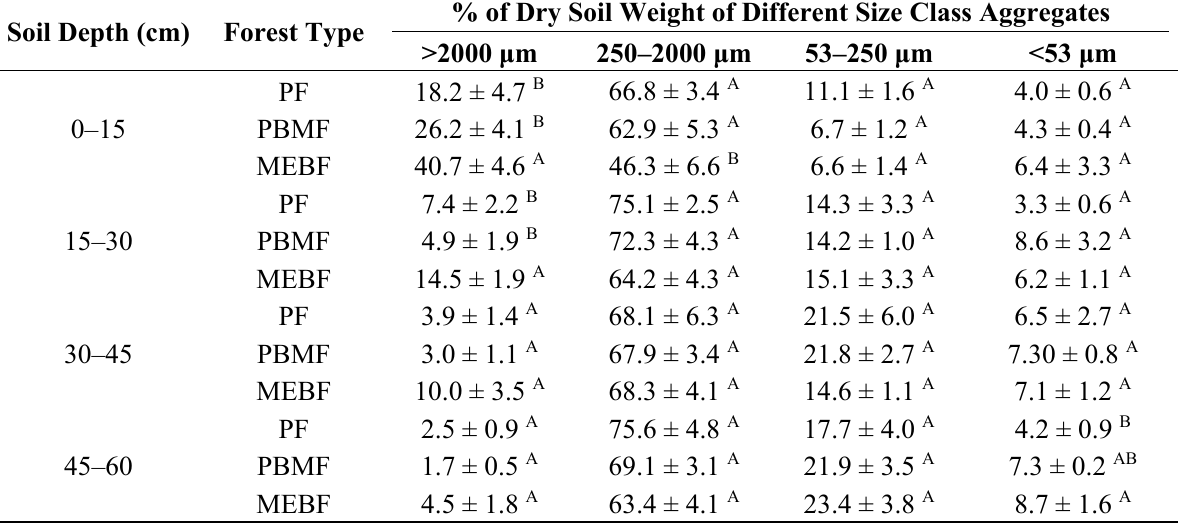
Table 4. The proportion of dry soil weight of different size class aggregates in the three